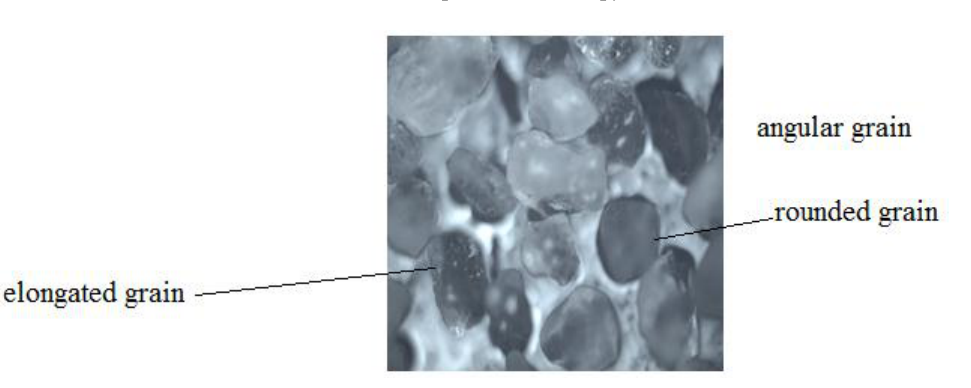
Figure 3: Micrograph of Biskra Dune Sand.